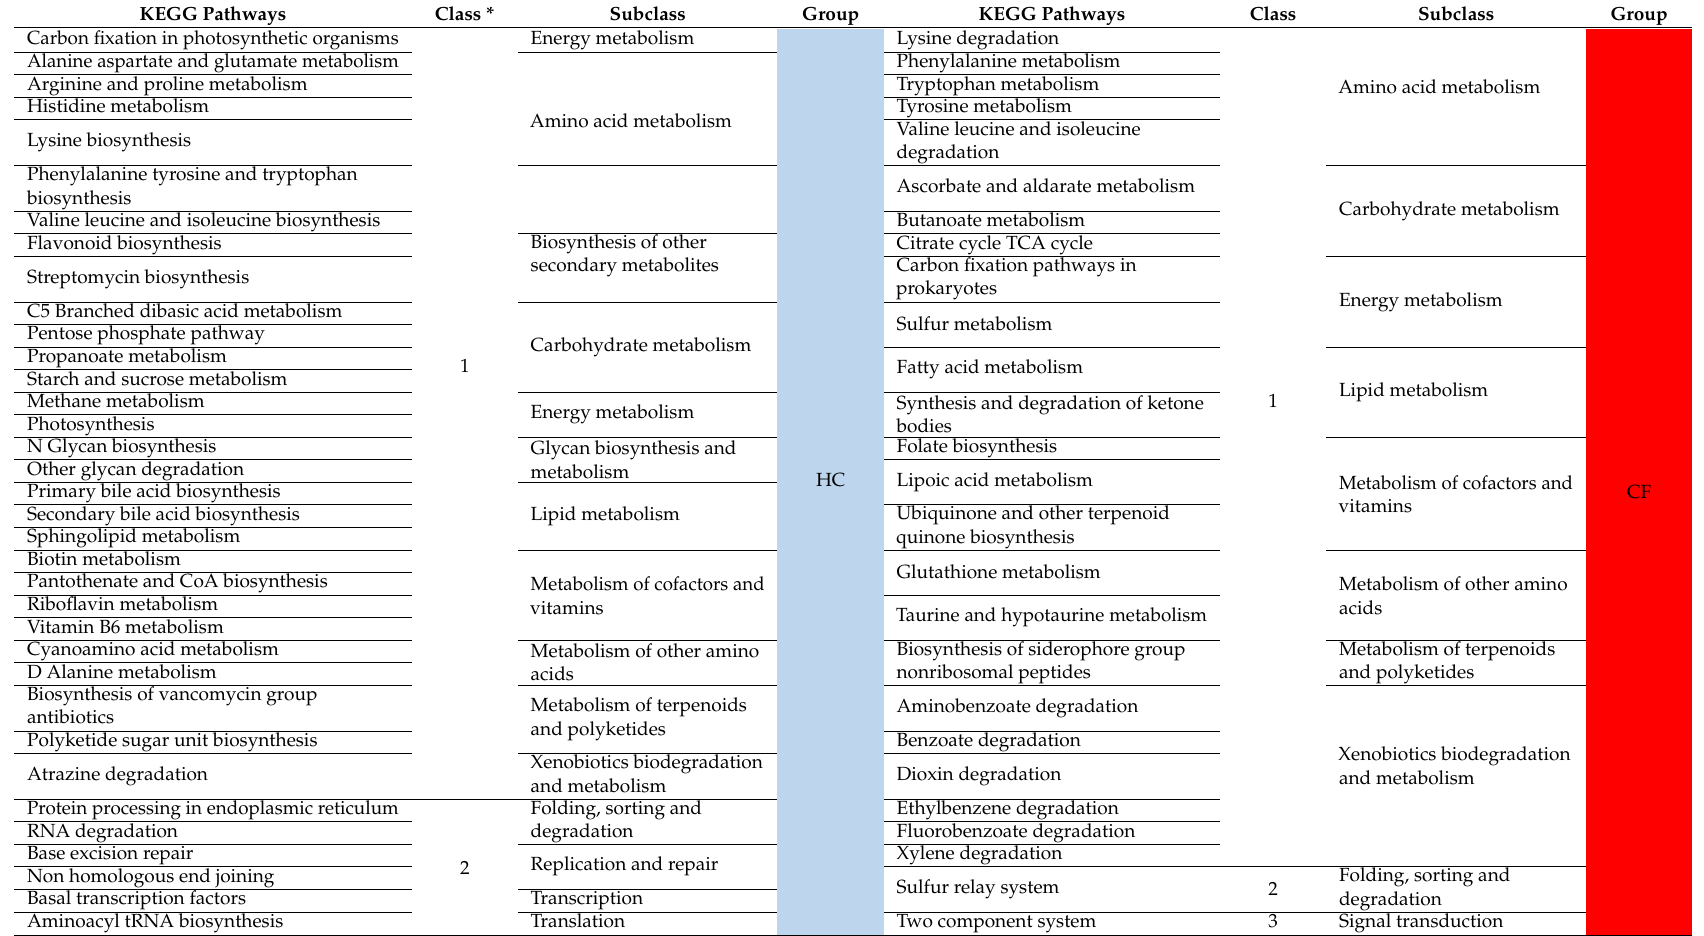
Table 3. Kyoto Encyclopedia of Genes and Genomes (KEGG) pathways associated with HC and CF